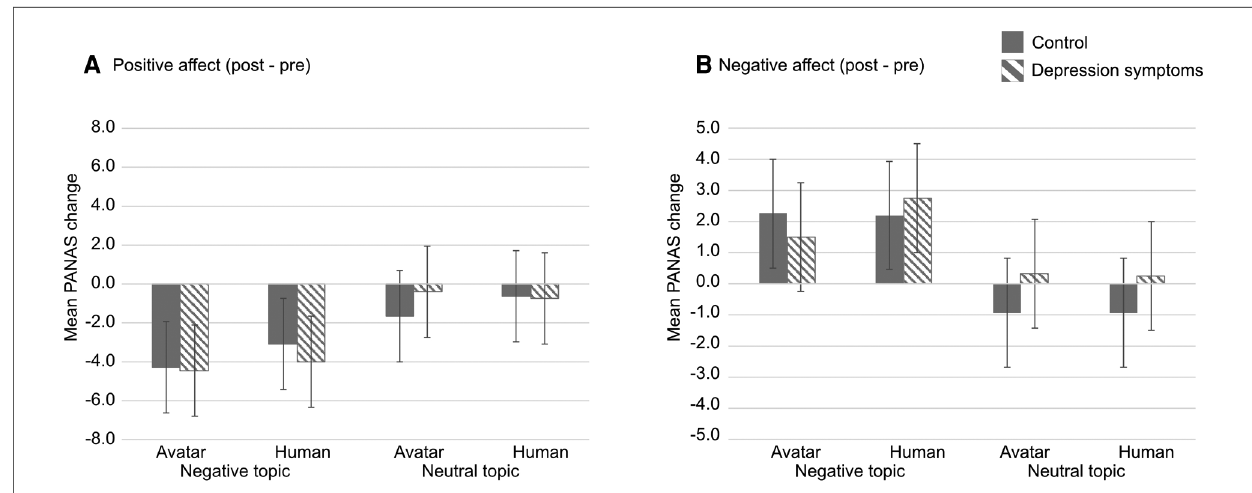
FIGURE 3 Result indicates the change of PANAS ’ s score between post- and pre-session in PANAS. ( A ) positive affect and ( B ) negative affect. Striped pattern boxes indicate the data of the depressed symptoms group, and solid boxes are the control group. Error bars indicate 95%